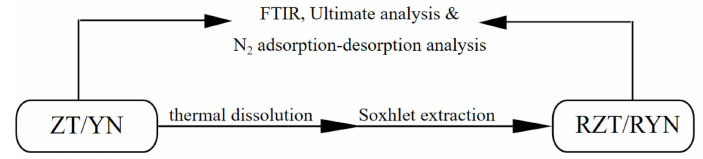
Figure 1. Thermal dissolution of ZT and YN in